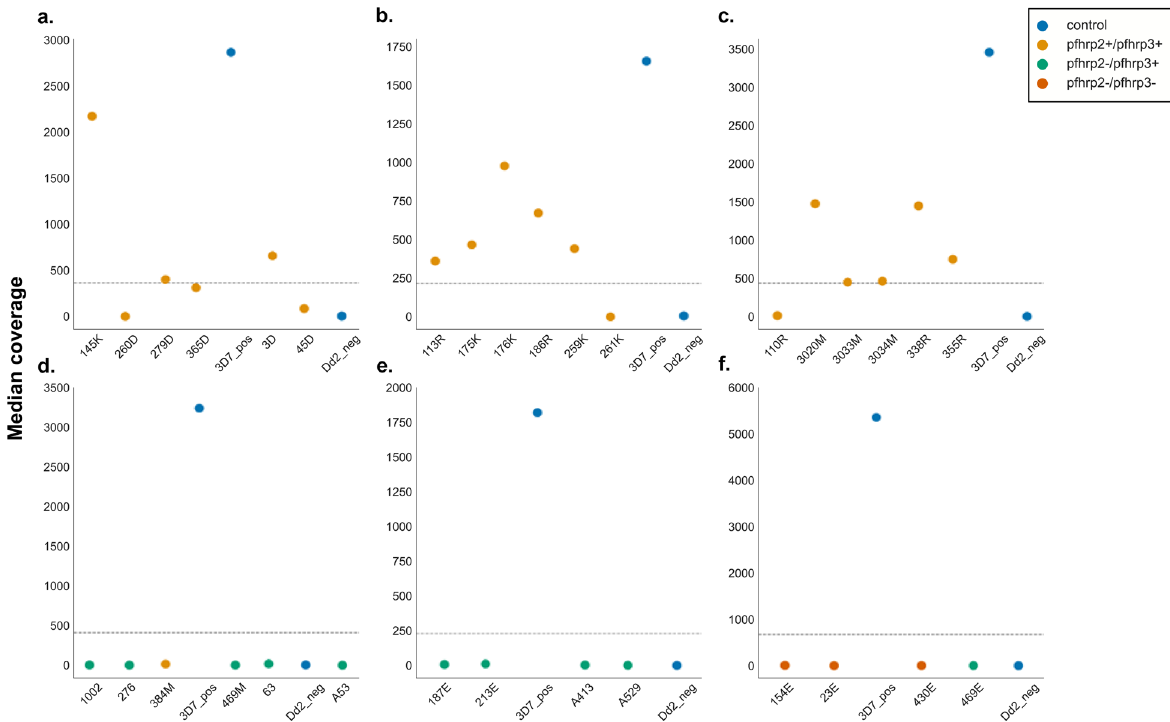
Figure 3. Positivity thresholds for previously analyzed TES sample dataset. Based on the positivity threshold established for each sequencing pool, calculated as the first octile between the median coverage of the Dd2 negative control and 3D7 positive control, largely reifies the findings from a previous analysis of these samples 9,16 . Notably, no samples previously assessed to be pfhrp2- were found to be putatively positive using this MinION assay. Positivity thresholds are shown here for sequencing runs ( a ) FL1_TES, ( b ) FL2_TES, ( c ) FL3_TES, ( d ) FL4_TES, ( e ) FL5_TES, and ( f )